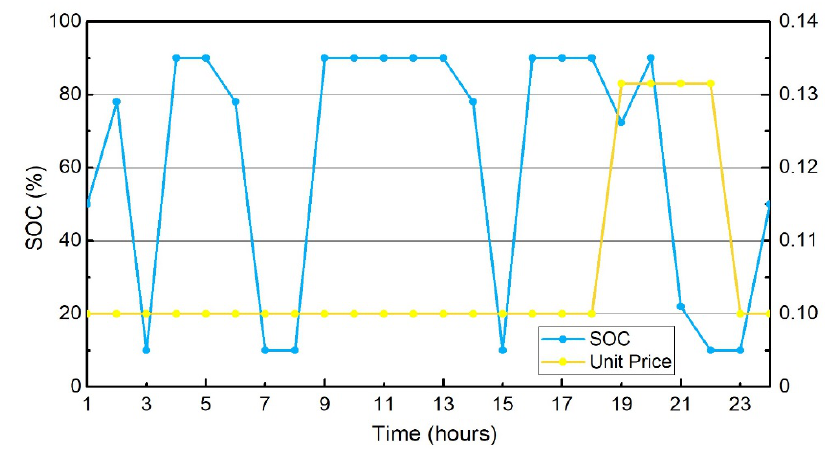
Figure 9. Case (3): State-of-charge of a battery with unit prices. Case (4) (DG integration with the PV, ESS, and grid): In the fourth case, the campus microgrid combined a diesel generator (DGen) with rooftop solar and a BESS structure to minimize the potential peak demand of energy from the utility grid, even during